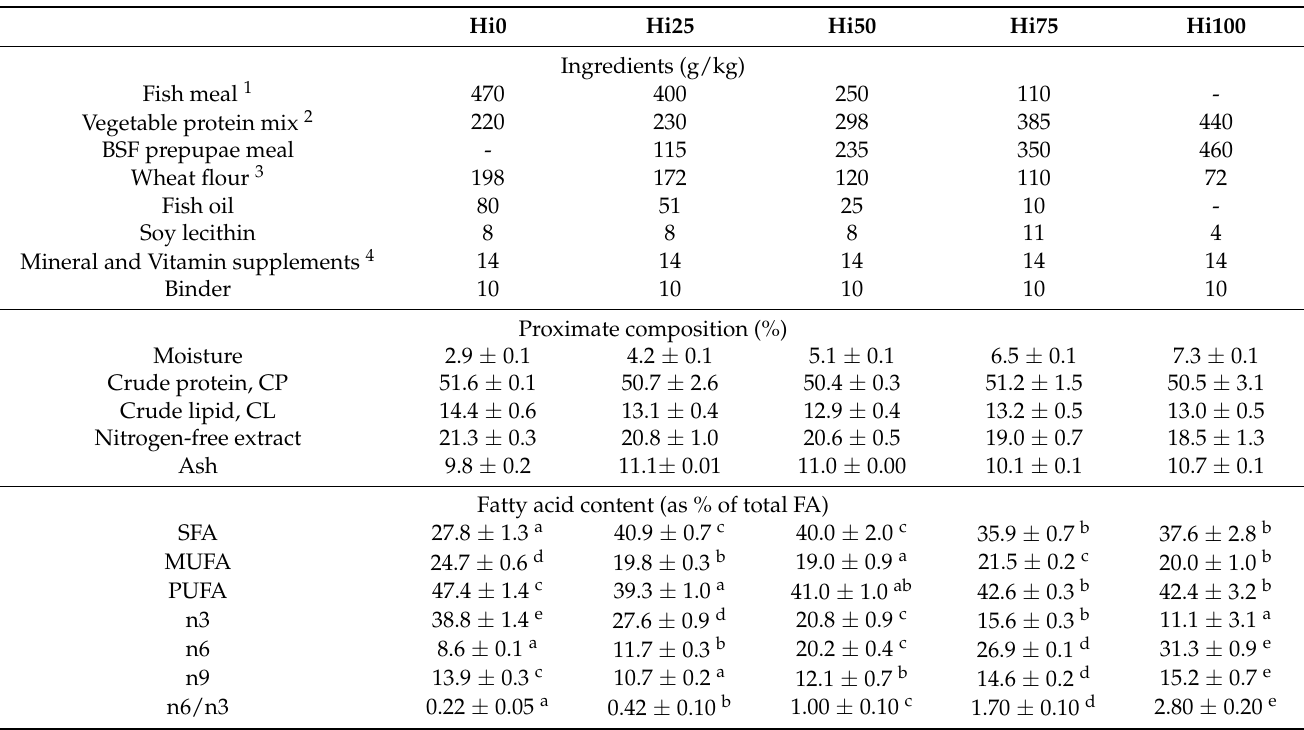
Table 1. Ingredients (as g/Kg) and proximate composition (g/100 g) of the experimental diets used in the present study according to Zarantoniello et al.